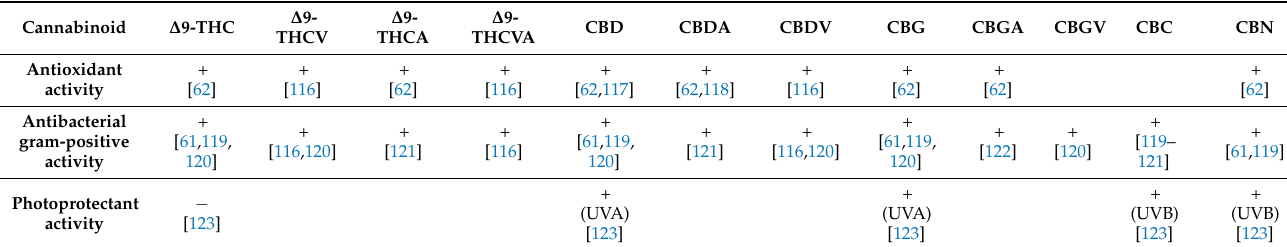
Table 4. Antioxidant, antibacterial and photoprotectant activity of various